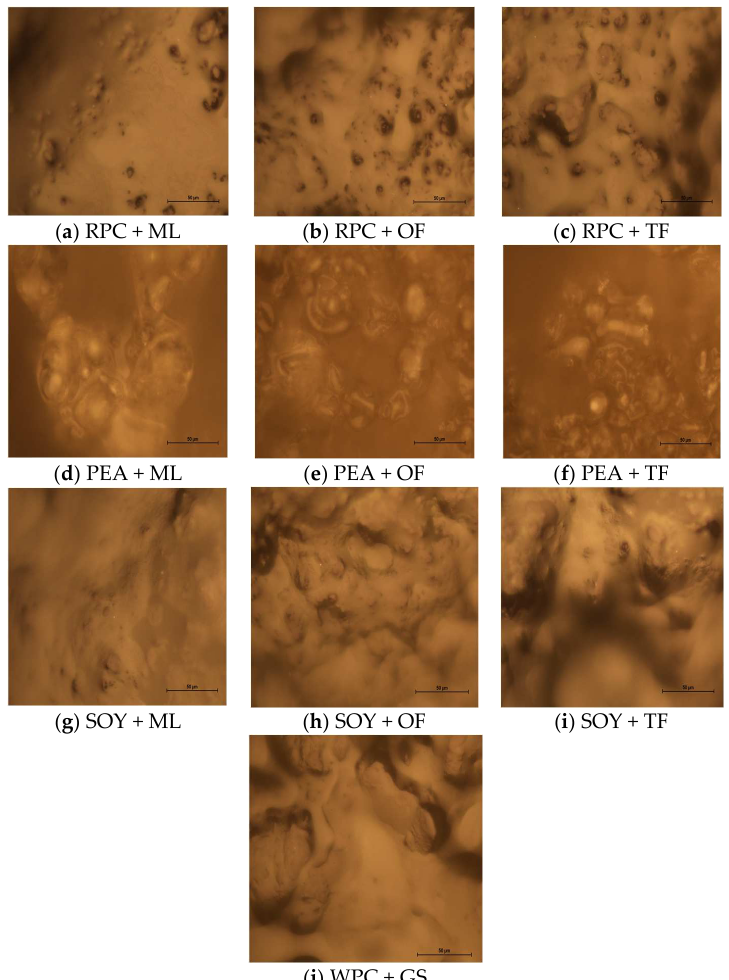
Figure 1. ( a – j ) Microstructure of the surface of the tested high-protein bars from the optical microscope (MAG: 400×). The method used to present photos of the microstructure of the surface for comparison for individual components.